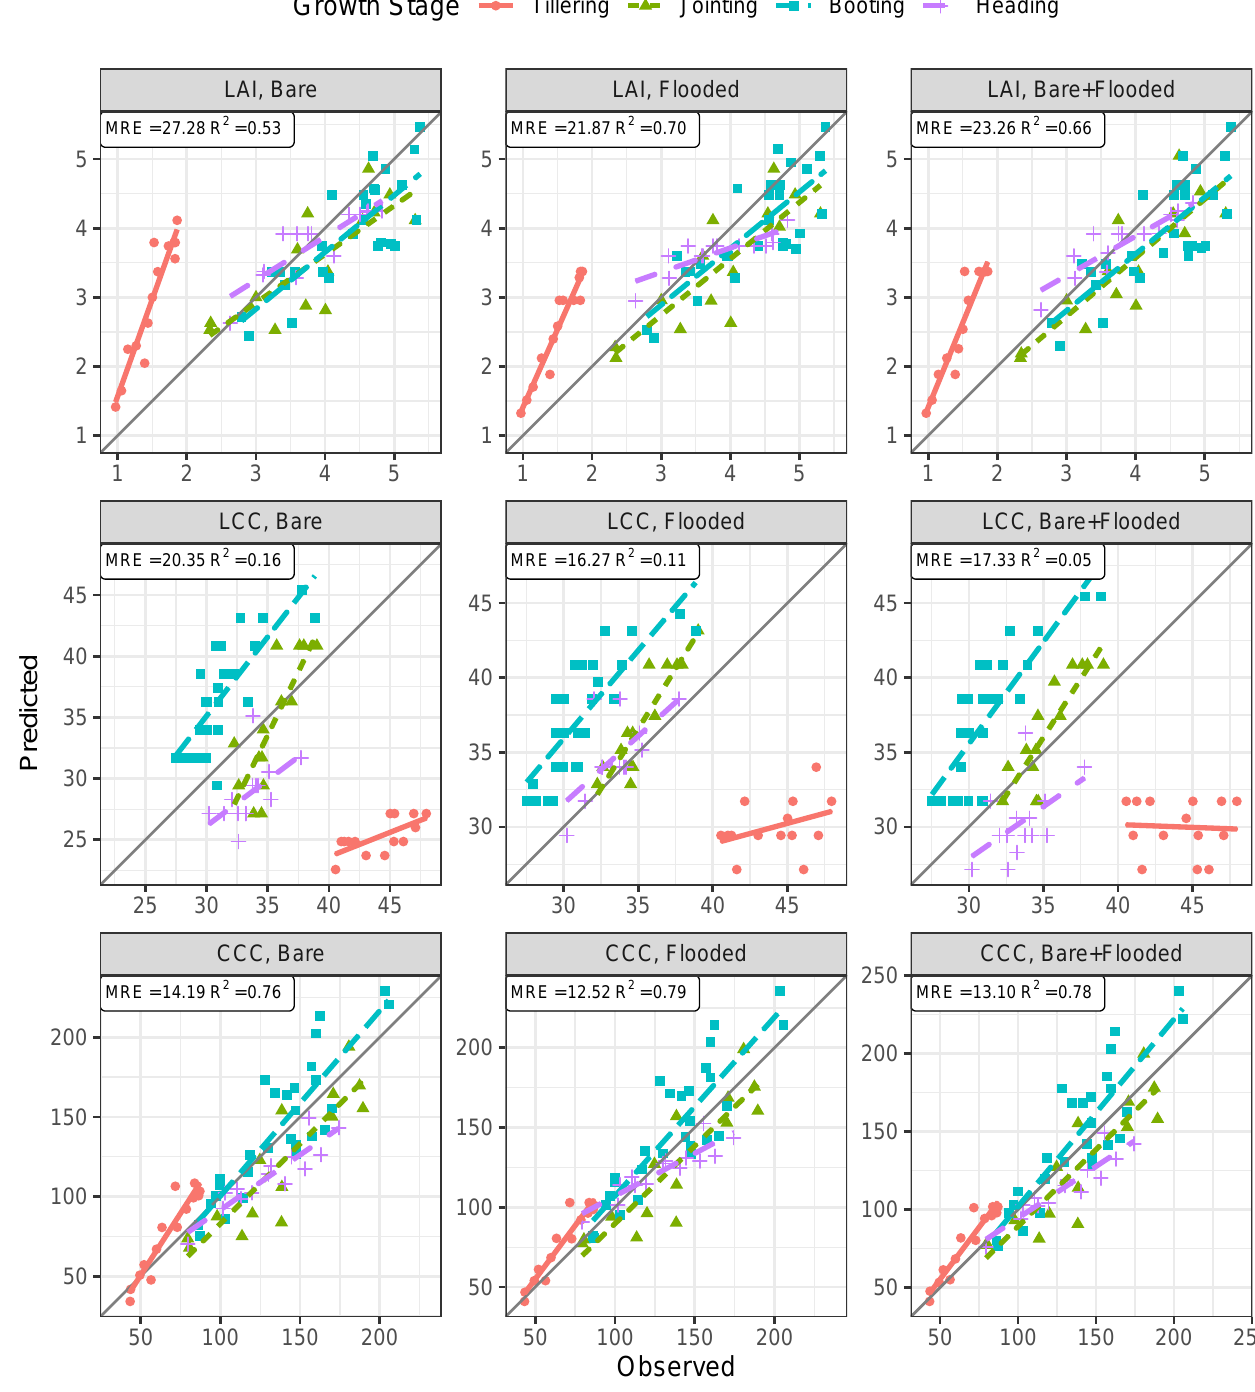
Figure 3. Observed vs predicted scatter and goodness-of-fit of PROSAIL-LUT approach with different rsoil setup ( Bare for bare soil signatures, Flooded for flooded soil signatures, Bare+Flooded for combination of both bare and flooded soil signatures) for paddy rice leaf area index ( LAI , unitless), leaf chlorophyll content ( LCC , µ g cm − 2 ), and canopy chlorophyll content ( CCC , µ g cm − 2 ). Entire dataset from tillering to heading growth stages are used together. Gray line is 1:1 line. Colored line is linear fitted line between observed and predicted values for corresponding growth